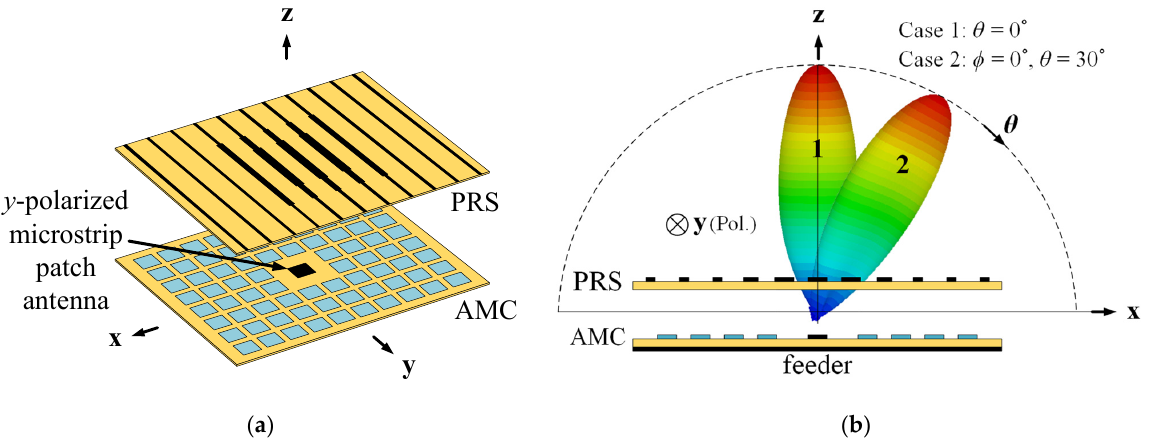
Figure 1. Overviews of ( a ) the proposed FPC antenna that can scan the main beam on the xz -plane ( φ = 0 ◦ ) and ( b ) its beam-scanning scenarios.